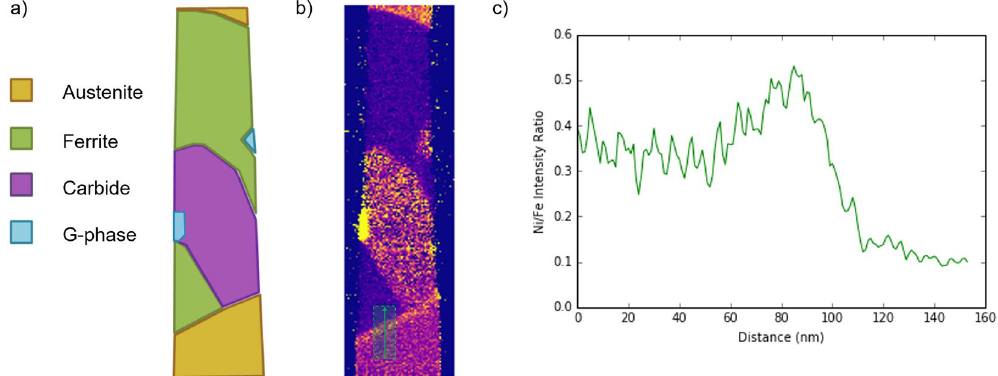
Figure 7. ( a ) Diagram displaying the different phases associated with the corresponding slice ( b ) through the STEM-EDX volume. ( b ) Slice displaying the ratio of Ni to Fe intensity through the centre of the STEM-EDX volume. An increased Ni/Fe ratio is clearly seen at the lower boundary between austenite and ferrite. ( c ) Line profile of the ratio of Ni to Fe intensity in the slice shown in ( b ), taken from the red region indicated in ( b